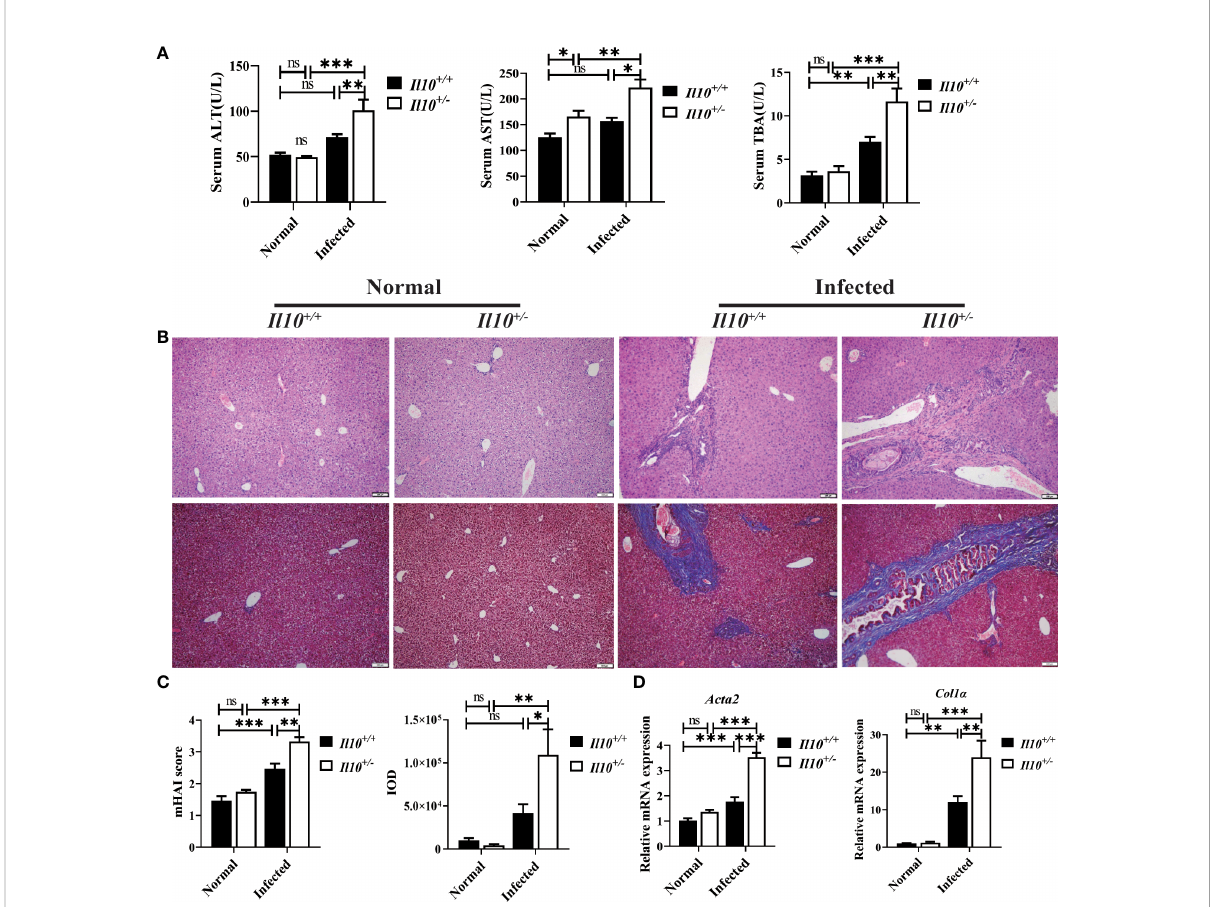
FIGURE 1 IL-10 de fi ciency aggravates hepatobiliary injury caused by C sinensis infection. (A) Serological levels of ALT, AST, and TBA. (B) Histopathological changes in the liver were observed by H&E staining, and fi brosis was examined by Masson ’ s trichrome staining. (C) The statistical analysis of mHAI score and fi brotic area in the liver. (D) The expression levels of Acta2 and Col1 a in the liver were detected by quantitative RT-PCR. Compared with indicated group, * P < 0.05, ** P < 0.01, *** P < 0.001, ns, no signi fi